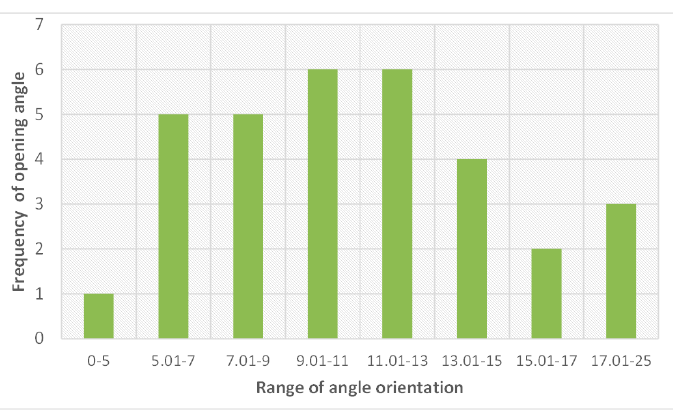
Figure 7. Histogram of spider web opening angle for sample SP5.